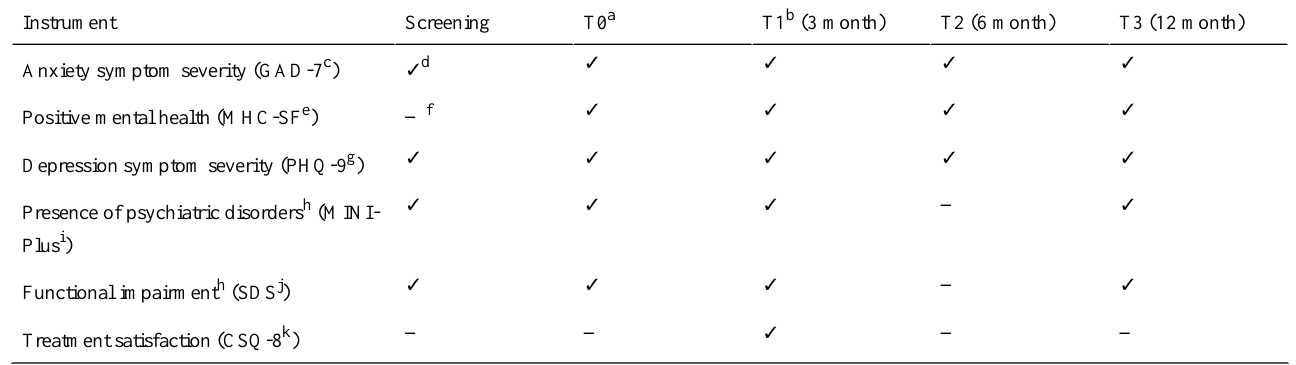
Table 1. Instruments per measurement